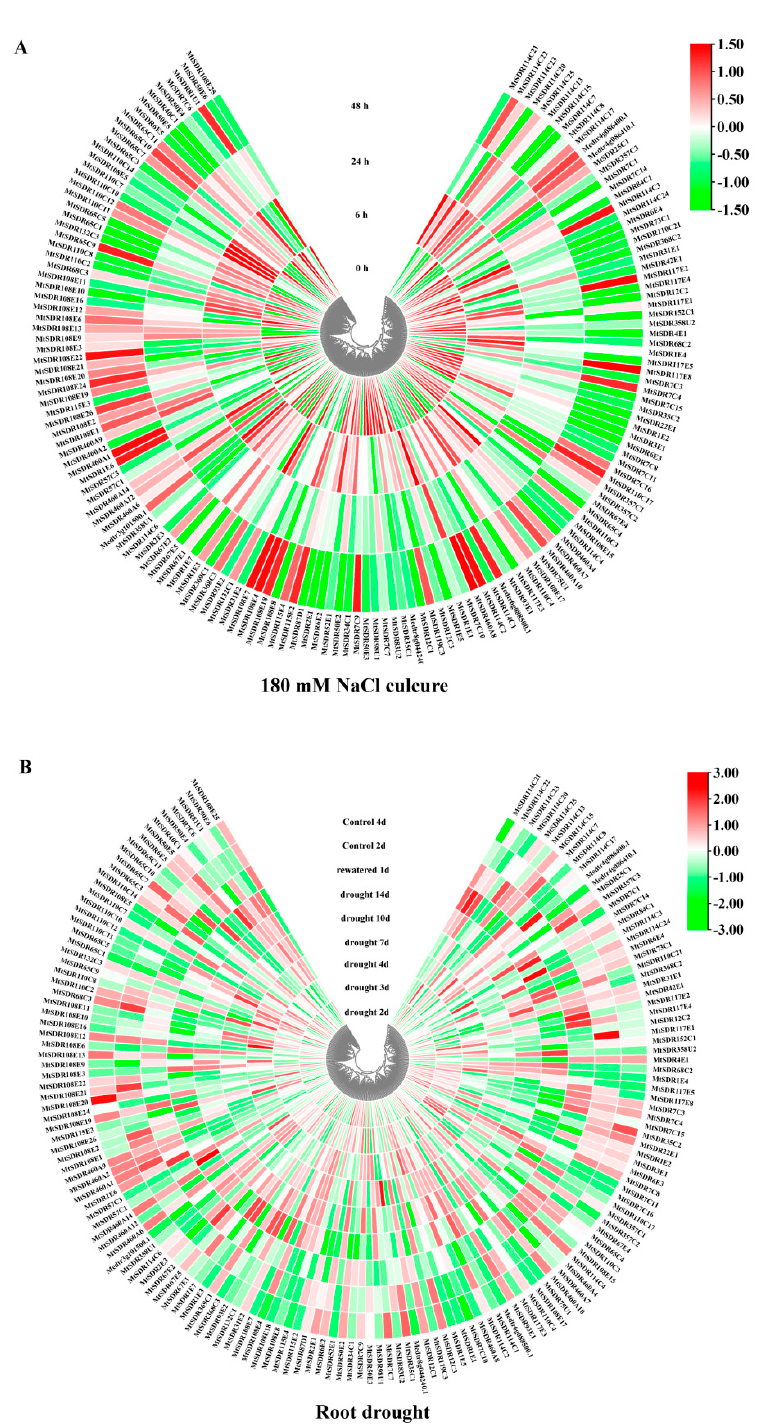
Figure 7. Heat map of MtSDR s expression in response to salt and drought stress. The expression data were collected from M. truncatula Gene Expression Atlas (MtGEA, https://mtgea.noble.org/v3/, accessed on 5 April 2021). ( A ) Two-week-old seedlings were treated with 180 mM NaCl for 0, 6, 24, and 48 h, respectively. ( B ) Twenty-four-day-old seedlings were withholding irrigation for soil drying for 14 d, followed by 1 d of rewatering.